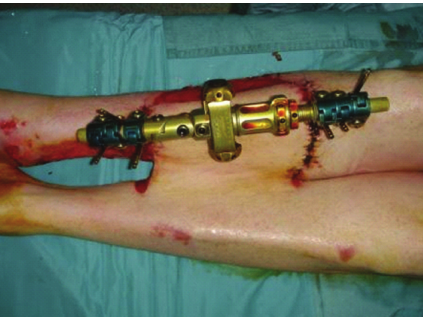
Figure 3: Donor site was covered with split-thickness skin graft.